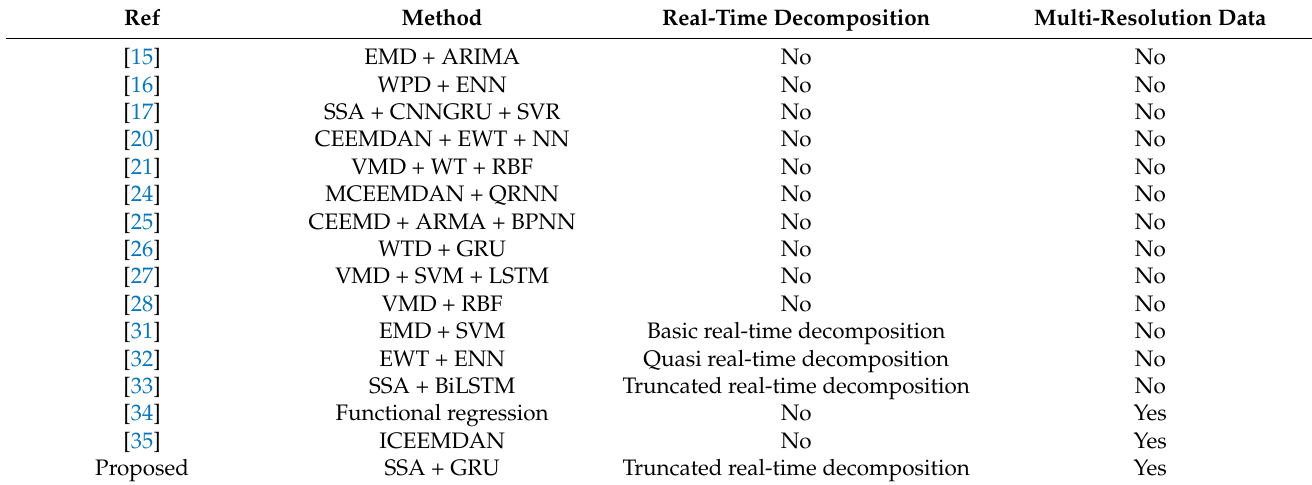
Table 1. The comparison of the proposed model with relevant research